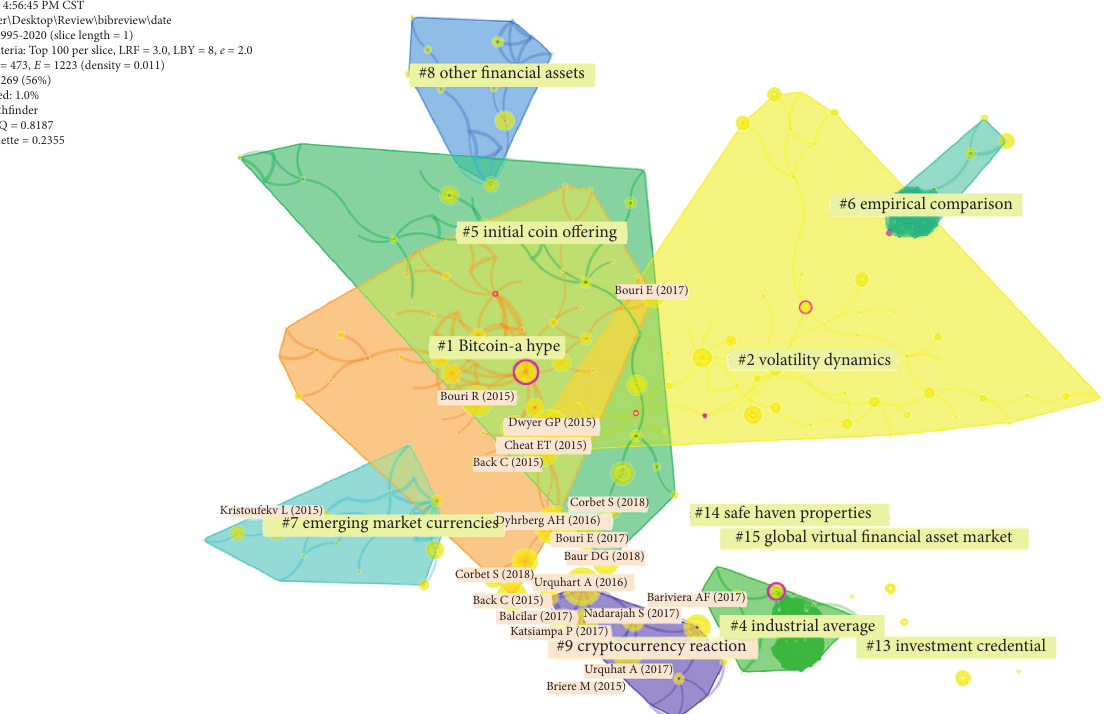
Figure 4: Clusters of cited references on DC/EP (1995–2020). Clusters are in different colors, and their labels are in red text. Landmark articles are labeled in black with font size proportional to citation counts. Table 1: Major clusters of cited references on DC/EP (1995–2020). Cluster # Size